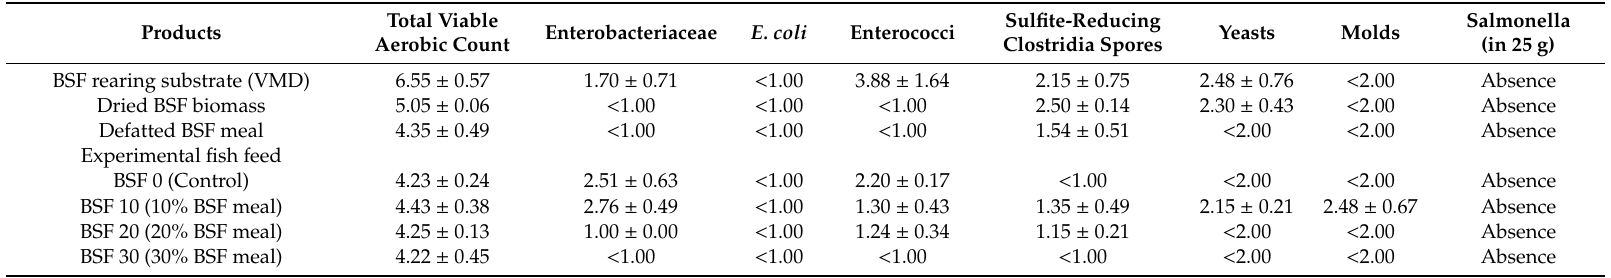
Table 4. Microbial contaminations along the production chain of the insect meal for fish feed production (insects are grown on VDM in mass rearing conditions); mean values (Log cfu g − 1 ) ± standard deviations of duplicate